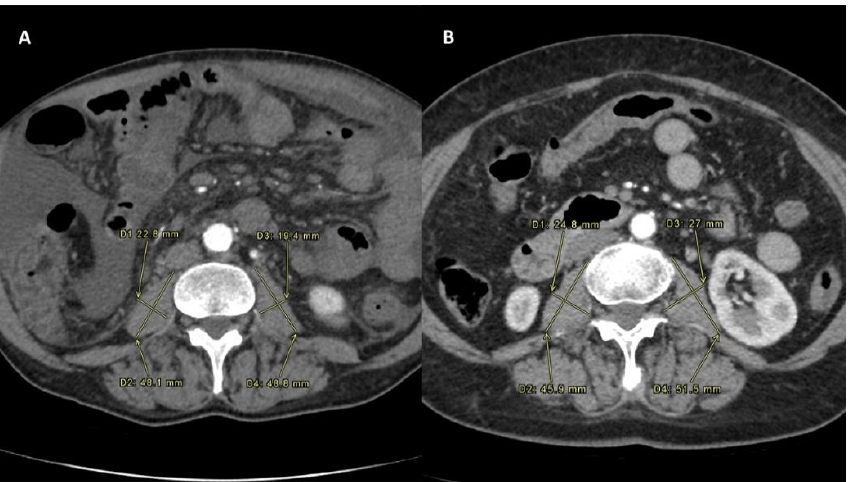
Figure 2. Sarcopenia status measured after the intra-arterial radioembolization in both the Sarcopenia group ( A ) and No-Sarcopenia group ( B ). All PMI measures were performed on the same level, which was between the third and the fourth lumbar vertebral body. To normalize the muscle mass for the patient’s height , this was divided by the square of the patients’ height. The PMI formula was PMI [mm/m 2 ]: [(minor diameter of left psoas + major diameter of left psoas + minor diameter of right psoas + major diameter of right psoas)/4]/height in m 2 [10].